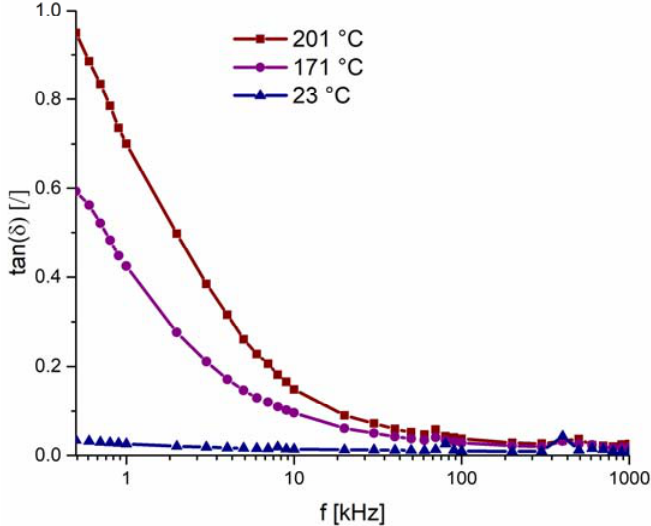
Figure A2. Tan δ of the sensor as a function of frequency measured at different temperatures. With increasing temperature, the dielectric losses increase exponentially as the driving frequency is reduced. This low-frequency dispersion in tan δ is related to the thermally induced increased leakage current of the BFO driving disc.